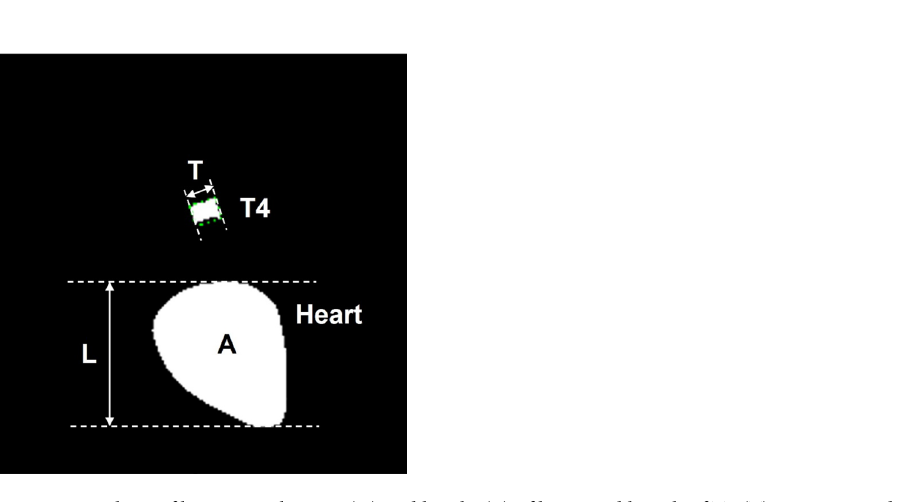
Figure 3. Analysis of binary mask. Area (A) and height (L) of heart and length of T4 (T) are measured. Height of the heart (L) was calculated by the coordinate value of the heart region at its radiographic position. T4 length (T) was measured as width of “minimum area rectangle” of T4